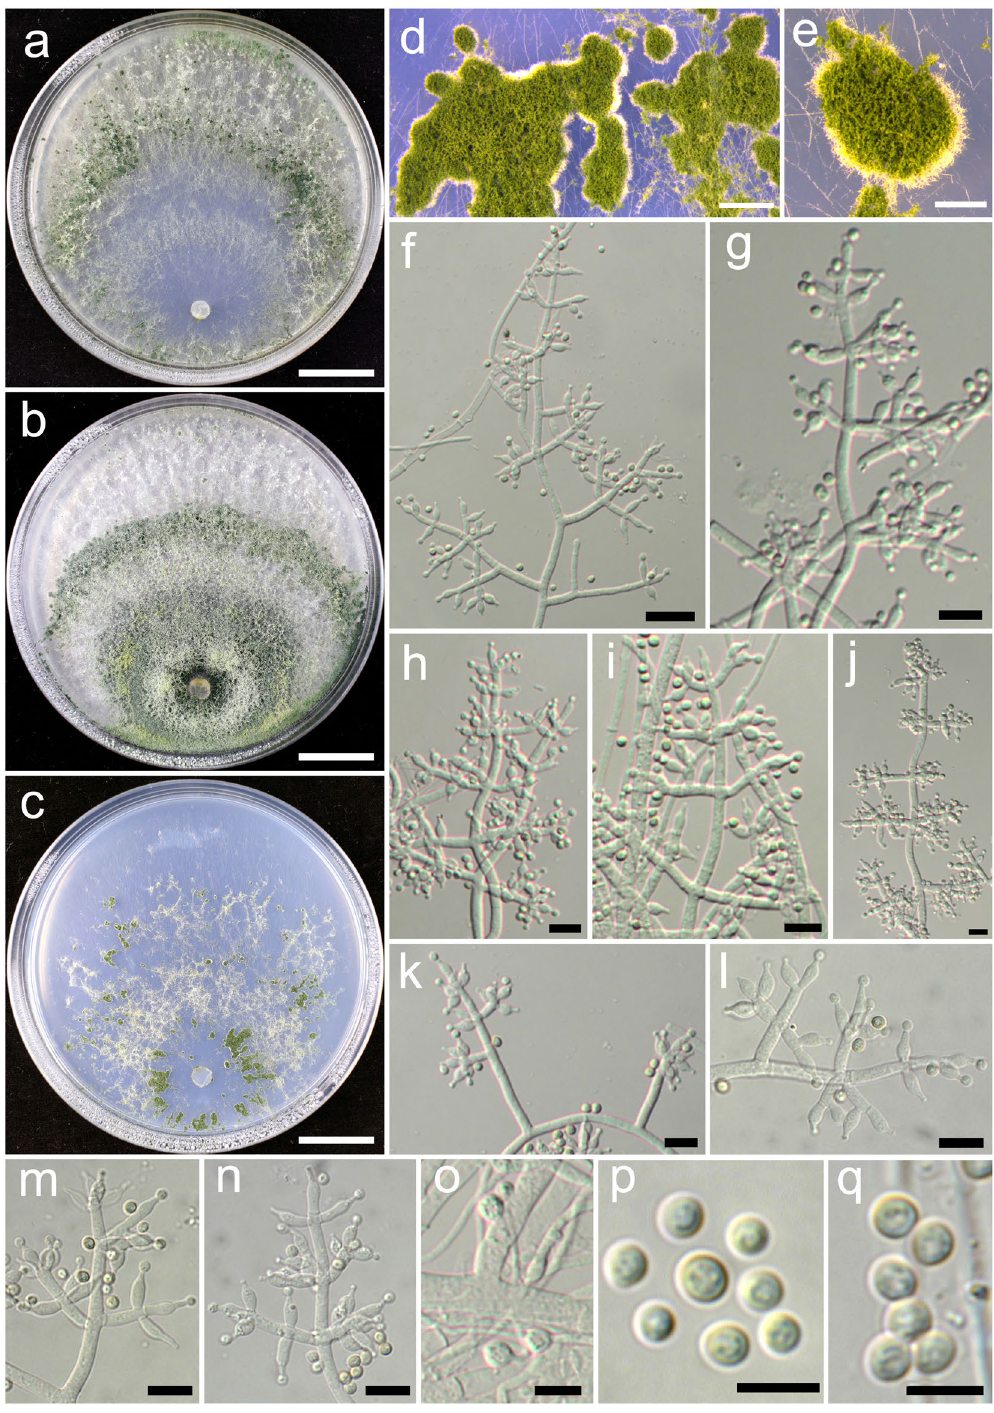
Figure 5. Trichoderma breve (HMAS 248844). ( a – c ) Cultures at 25 °C, 7 d (a. on CMD; b. on PDA; c. on SNA); ( d , e ) Conidial pustules (SNA, 7 d); ( f – n ) Conidiophores and phialides (f–j), ( l – n ). PDA, 2 d; ( k ). CMD, 2 d); ( o ) Chlamydospores (PDA, 2 d); ( p – q ) Conidia (PDA, 2 d). Bars: a–c = 20 mm. d = 400 μ m. e = 200 μ m. f = 20 μ m. g–o = 10 μ m. p–q = 5 μ